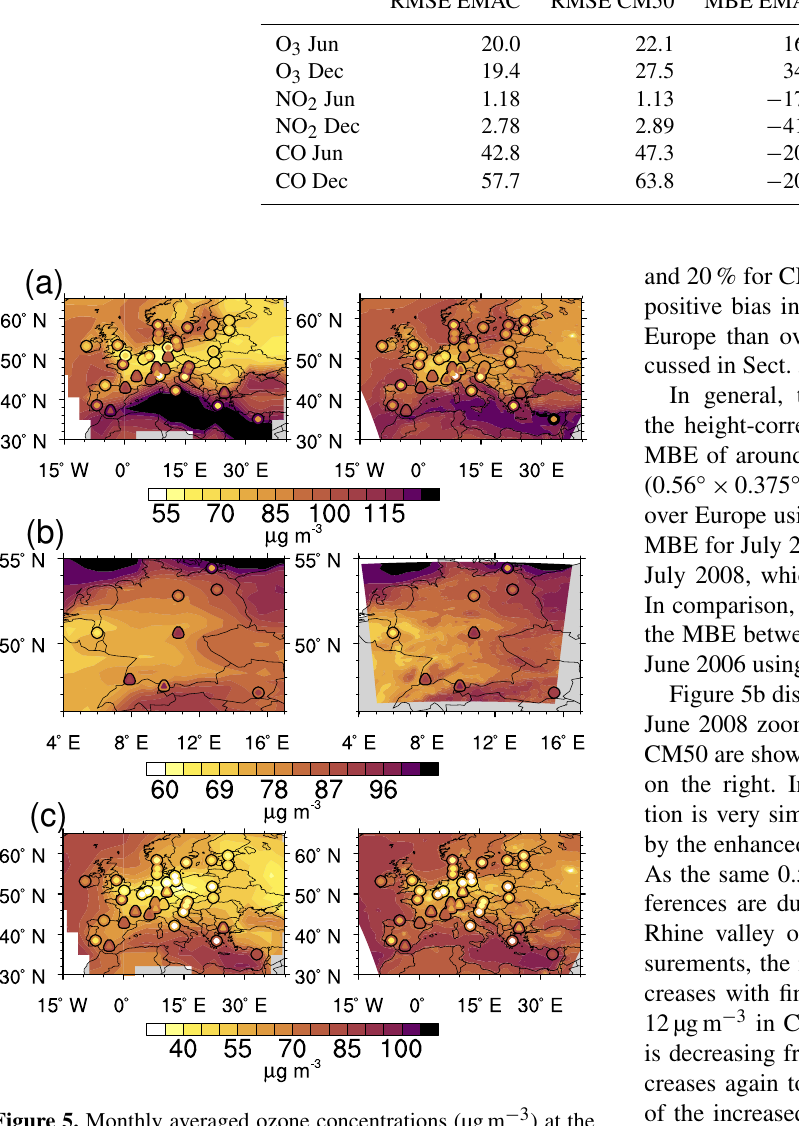
Figure 5. Monthly averaged ozone concentrations (µgm − 3 ) at the lowest model layer. The inner parts of the coloured dots show the monthly mean values measured at the corresponding stations, while the outer parts depict the simulated value corrected for the station elevation. Triangles indicate stations with an elevation higher than 800m, circles stations below that height. Panel (a) shows ozone concentration from EMAC (left) and CM50 (right) in June 2008, (b) ozone concentration for CM50 (left) and CM12 (right) in June 2008 and (c) ozone concentration for EMAC (left) and CM50 (right) in December